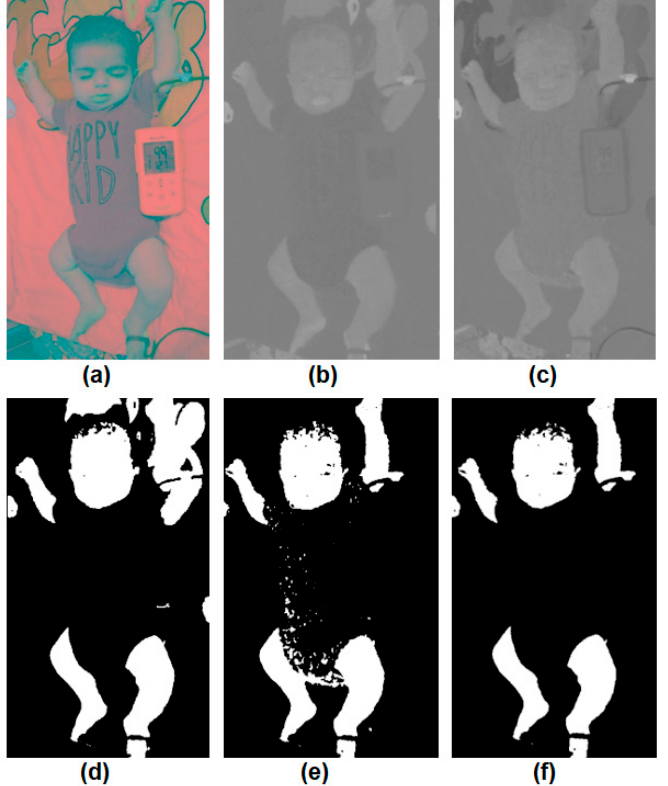
Figure 4. Skin detection. ( a ) LAB colour space, ( b ) A channel of the LAB colour space, ( c ) B channel of the LAB colour space, ( d ) binary image of the A channel, ( e ) binary image of the B channel, ( f ) multiplied image of binary images.